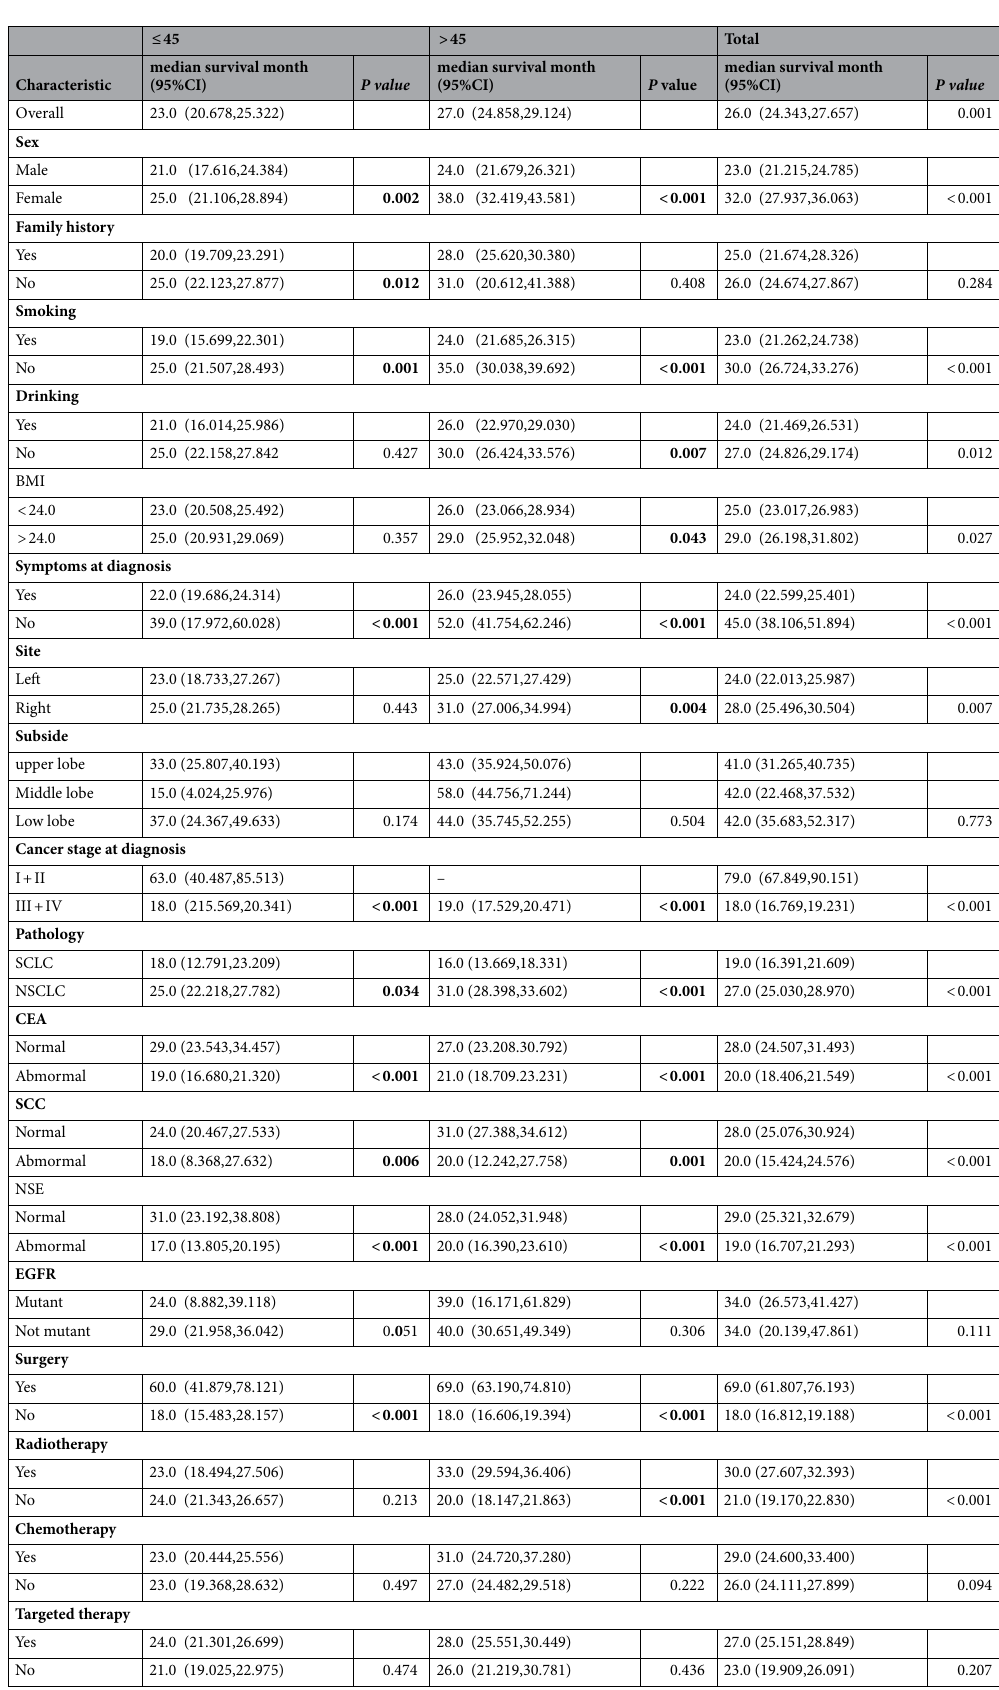
Table 3. Univariate analysis of prognostic factors for lung cancer patients by age